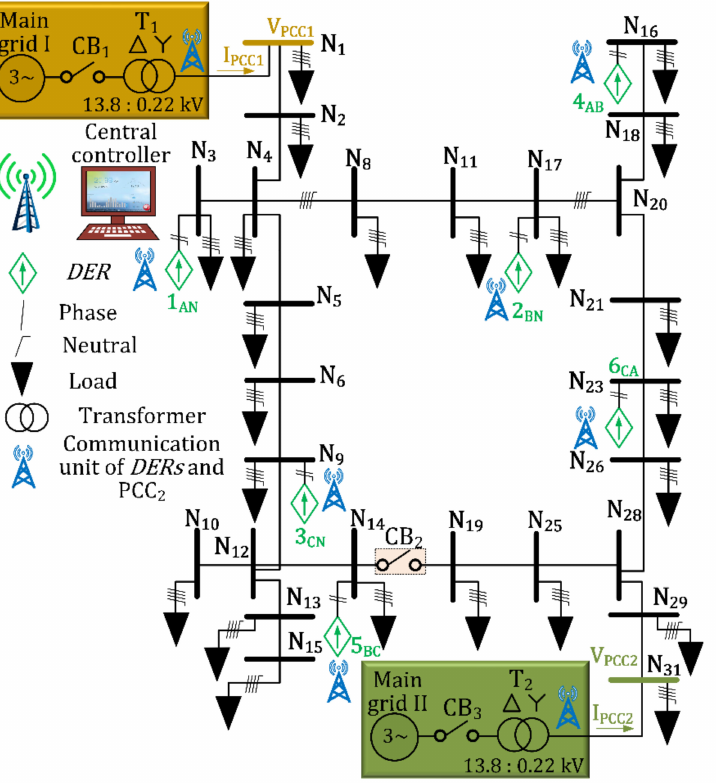
Figure 1. Considered low voltage microgrid with dispersed single-phase DERs, loads and multi-PCCs.